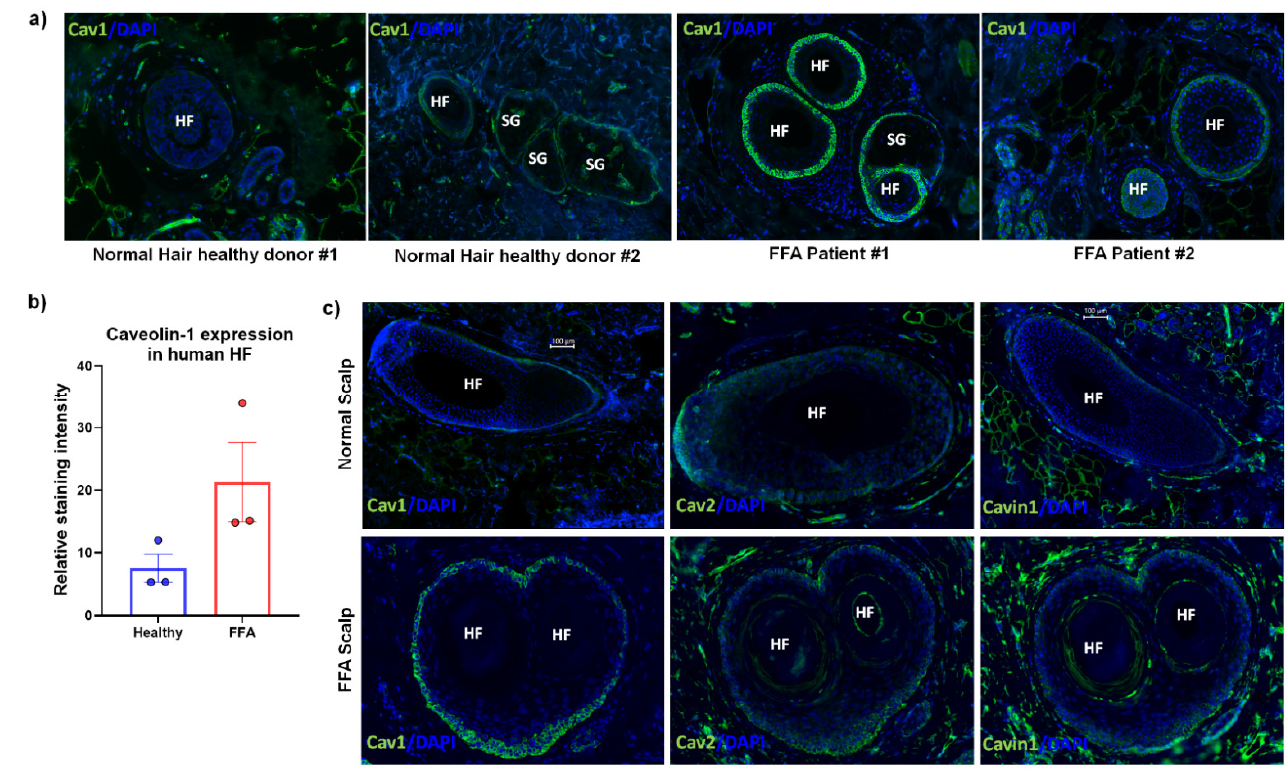
Figure 3. Elevated levels of Cav1 in FFA. ( a ) FFA scalp at the level of the bulge exhibits upregulation of Cav1 expression in comparison to normal scalp from the healthy human donors. HF: Hair follicle; SG: Sebaceous gland. ( b ) Quantification of Cav1 expression from basal layer of outer root sheath cells with error bars corresponding to SEM from n = 3 different donors. ( c ) Levels of other structural components of caveolae (Cav2 and Cavin1/PTRF) remain unchanged in comparison to healthy normal scalp, thus indicating a Cav1-specific effect.